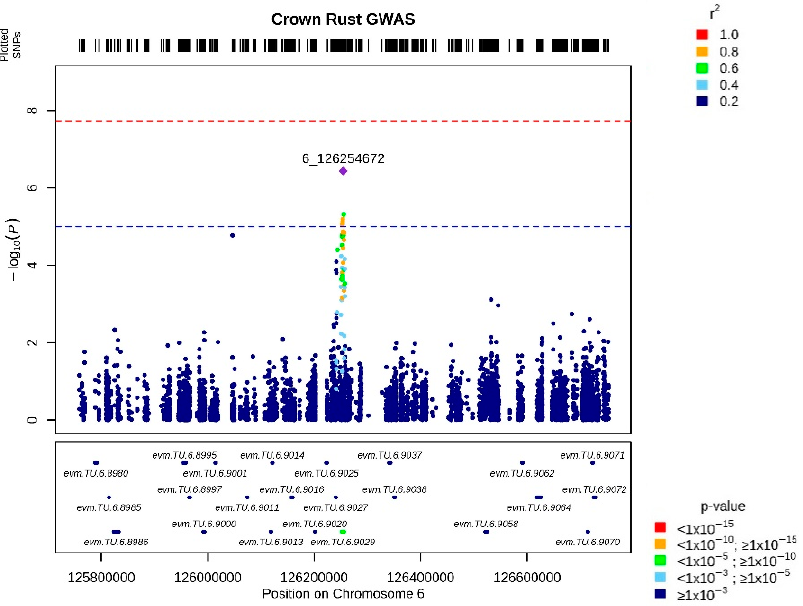
Figure 3. LocusZoom plots of the QTL associated with CRR from the GCTA analysis. Plots show the regions around the most significant SNPs. SNPs are plotted as the − log 10 of the p -value (box on the top). The LD.Measure function from LDcorSV R-package [35] was used to estimate the linkage disequilibrium ( r 2 ) between the most significant marker in that region and all the markers within a 100 Mbp window; each SNP’s r 2 is color-coded, as well as the p -value of the genes measured through MAGMA analysis (box on the bottom). The red dotted line refers to the Bonferroni threshold, while the blue horizontal line indicates the arbitrary cutoff of − log 10 ( p -value) = 5. Each plot refers to the association of CRR to CR-QTL2.1 ( a ), CR-QTL2.2 ( b ), CR-QTL3 ( c ), CR-QTL4 ( d ), CR-QTL6 ( e ), respectively.